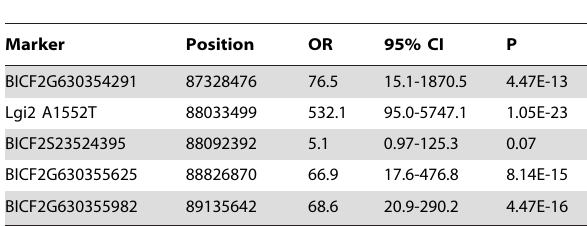
Table 1. Four highly-associated SNPs spread across the linked 1.7 Mb homozygosity region, together with the c.1552A . T mutation, were genotyped and tested for association from 28 BFJE cases and 112 healthy controls.